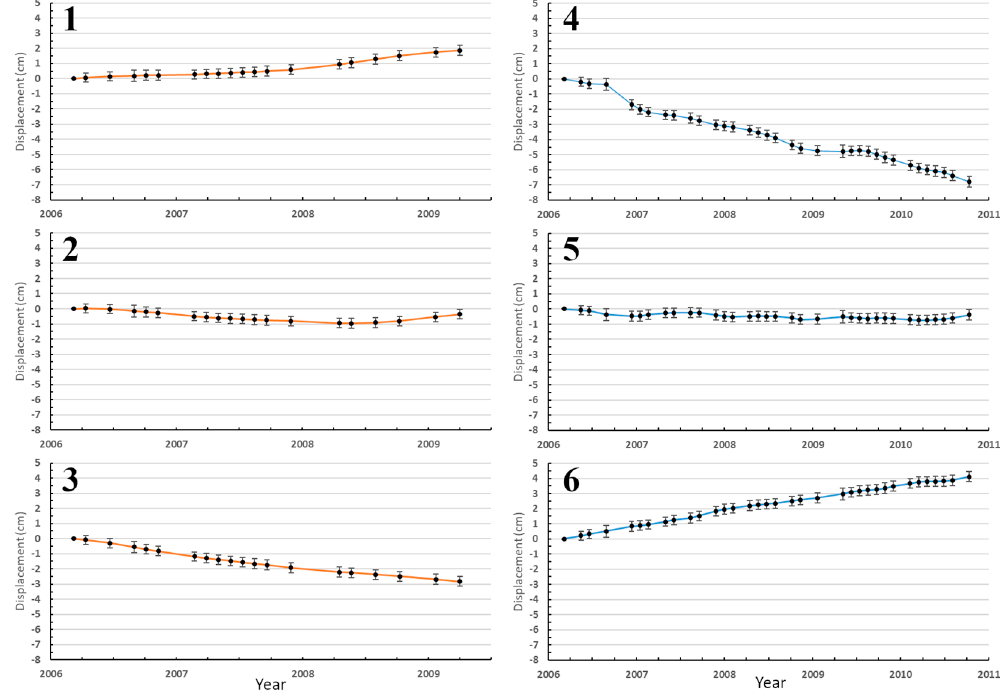
Figure 7. Time series of LOS displacements for selected pixels representing three different areas with different displacement patterns. Subfigures 1 and 4 show the displacement obtained at the Teneguía Volcano (pixels 1 and 4 in Figure 6). Subfigures 2 and 5 show two stable points (pixels 2 and 5 on Figure 6). Subfigures 3 and 6 show the displacement of two pixels (3 and 6 in Figure 6) in the southern part of Cumbre Nueva with significant LOS displacement. Vertical axis corresponds with the displacement measured in cm. The left-hand column shows ascending orbit results and the right-hand column descending orbit results. See Figure 6 for pixel locations.